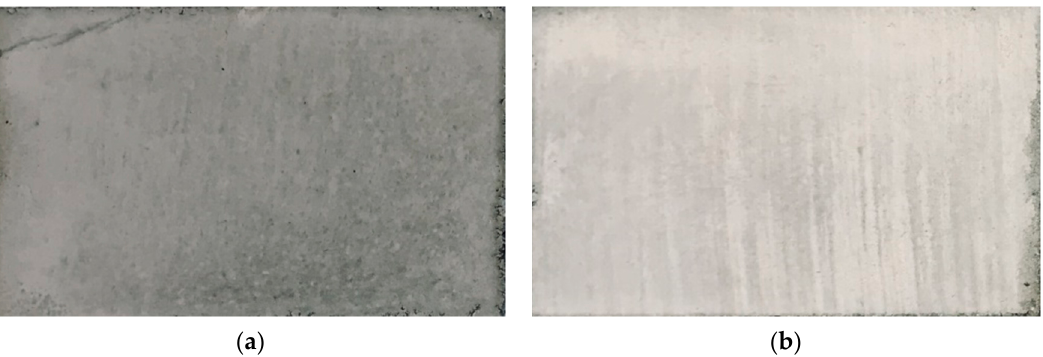
Figure 7. Failure surface of the interface between the aggregate and the QM after the IFT test (effects of the amount of FADPs); ( a ) F-00-0, ( b ) F-15-0.